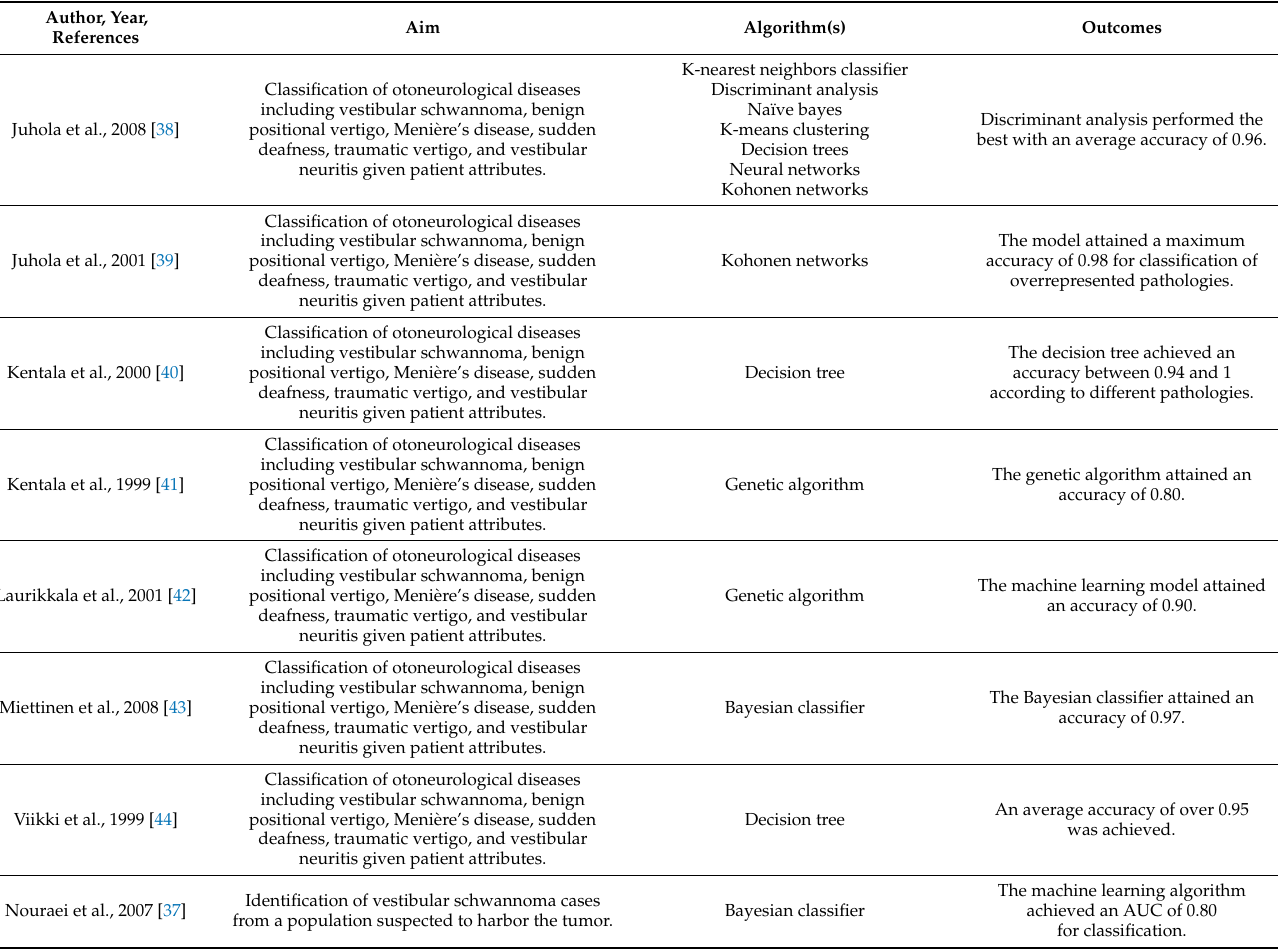
Table 2. Summary of the manuscripts with machine learning applications for disease